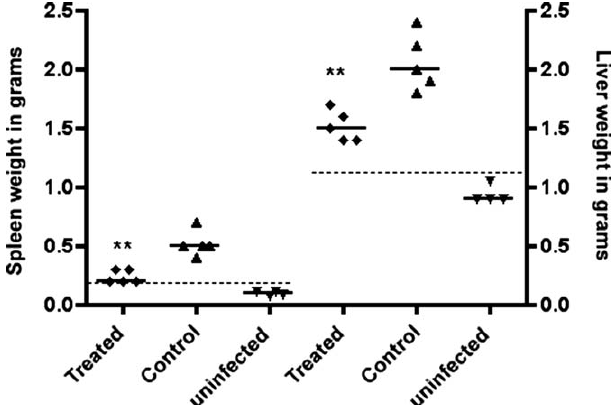
Figure 3. Long-Course Treatment with K11777 of Mice Infected with S. mansoni Retards Worm Growth Representative worms treated with K11777 in the experiment outlined in Figure 1 are shown.